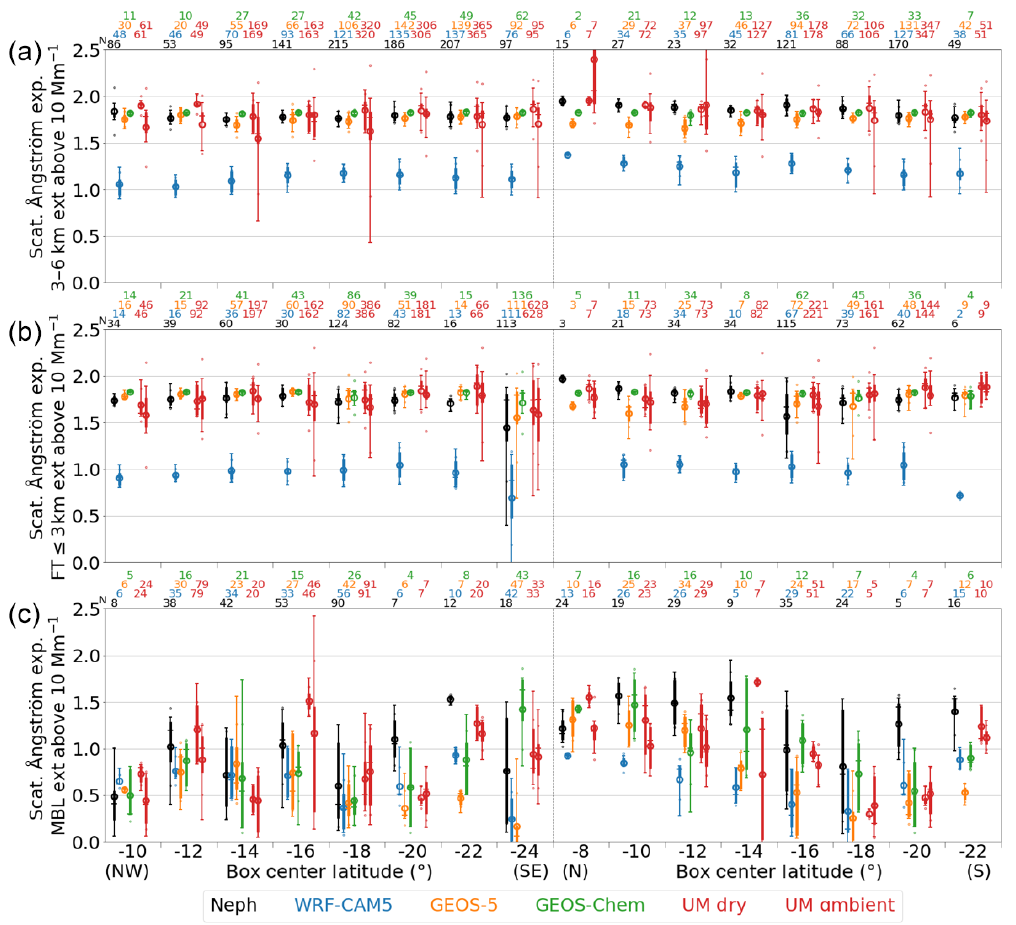
Figure 12. Same as Fig. 6 but for the scattering Ångström